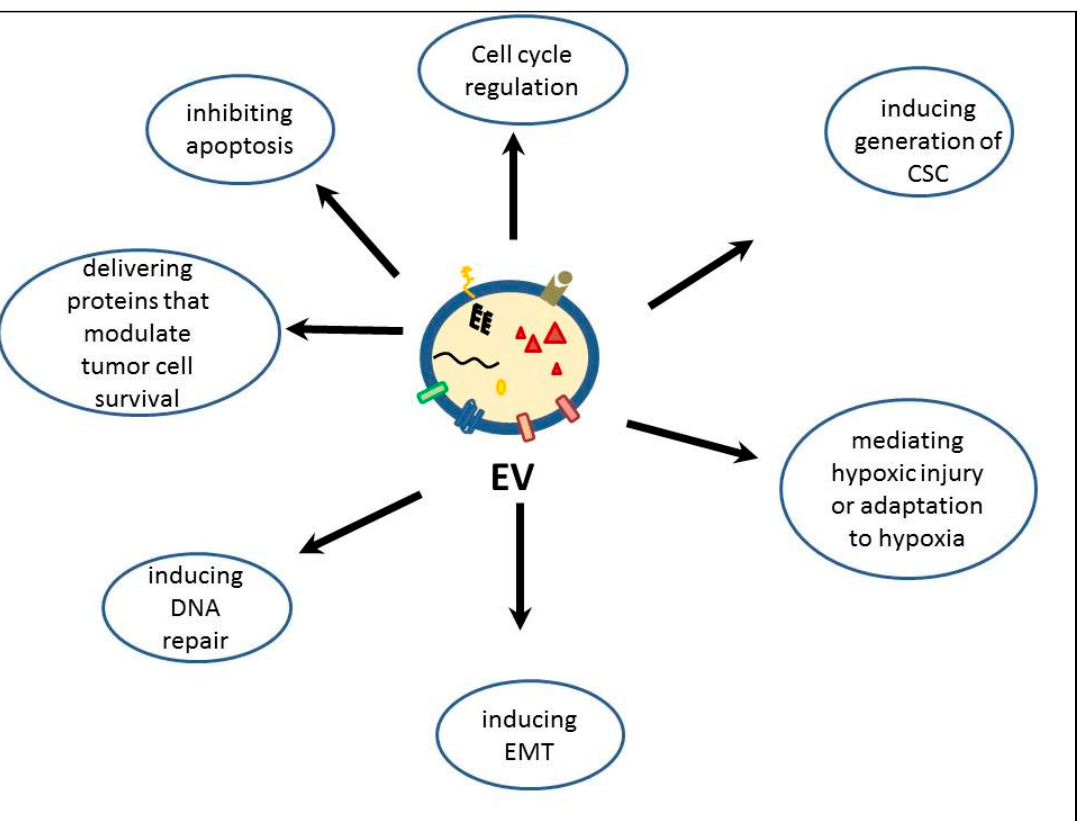
Figure 3. Functions of extracellular vesicles with a role in modulating radiation response. EV- extracellular vesicle; CSC-cancer stem cell; EMT-epithelial-mesenchymal transition.